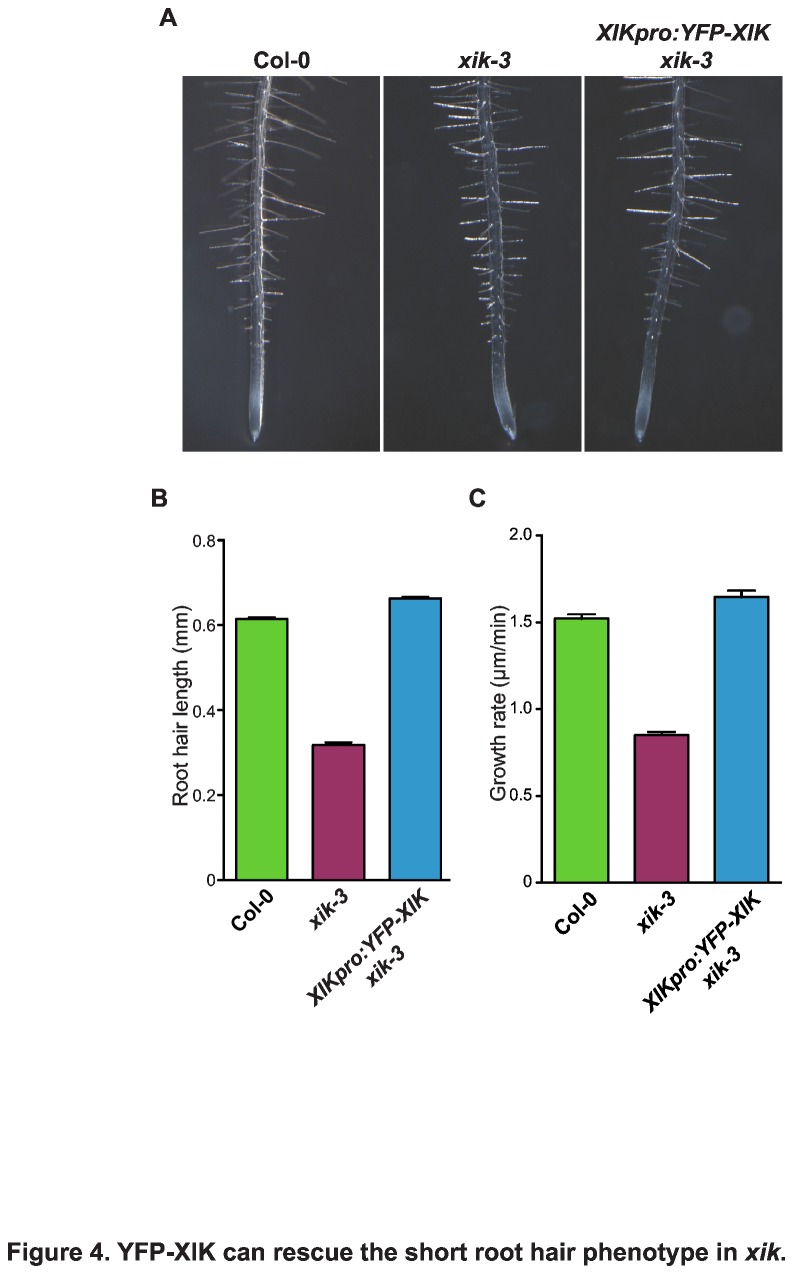
YFP-XIK can rescue the short root hair phenotype in xik.(A) Root hairs of XIKpro:YFP-XIK
xik-3 seedlings displayed long root hairs similar to those of Col-0. Pictures were taken with five day old seedlings grown on vertical growth media solidified with phytagel.(B) Lengths of mature root hairs. Root hairs of XIKpro:YFP-XIK
xik-3 showed similar length as those of wild type (n=730 Col-0; n=370 xik-3; n=660 XIKpro:YFP-XIK
xik-3). Error bars represent standard error of the mean.(C) Average growth rate of root hairs in XIKpro:YFP-XIK
xik-3 was similar to those of Col-0. Growth rates were measured in 10 second intervals (n=1350 Col-0; n=1080 xik-3; n=471 XIKpro:YFP-XIK
xik-3). Error bars represent standard error of the mean.